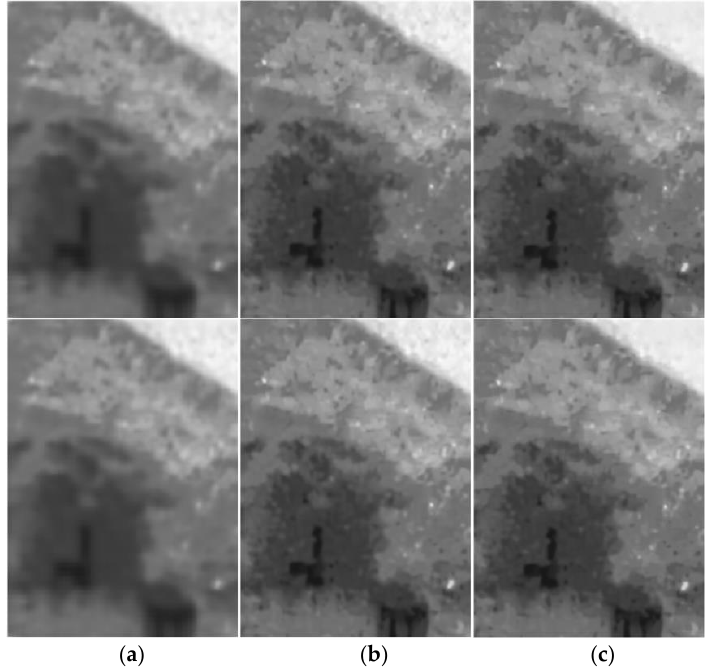
Figure 8. Verify the effectiveness of the RPCA in the filtering process. ( a ) the results of the RPCA with = 0.1; ( b ) the results of the RPCA with = 0.9; ( c ) the results of the RPCA with the adaptive parameters.